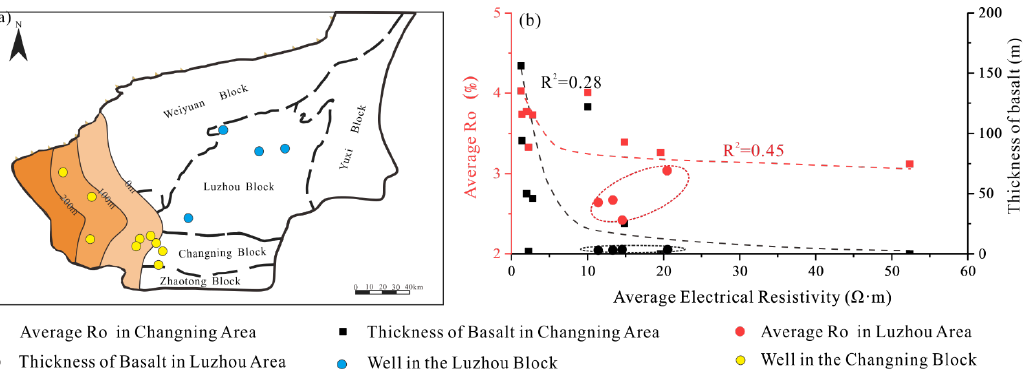
Figure 12. Relationship between resistivity and Ro/basalt thickness in the southern Sichuan Basin. ( a ) Basalt thickness and well locations in Sichuan Basin (blue spots are wells at the Luzhou block and yellow spots are wells at the Changning block. ( b ) Relationship between resistivity and Ro/basalt thickness at the Luzhou block and Changning block.